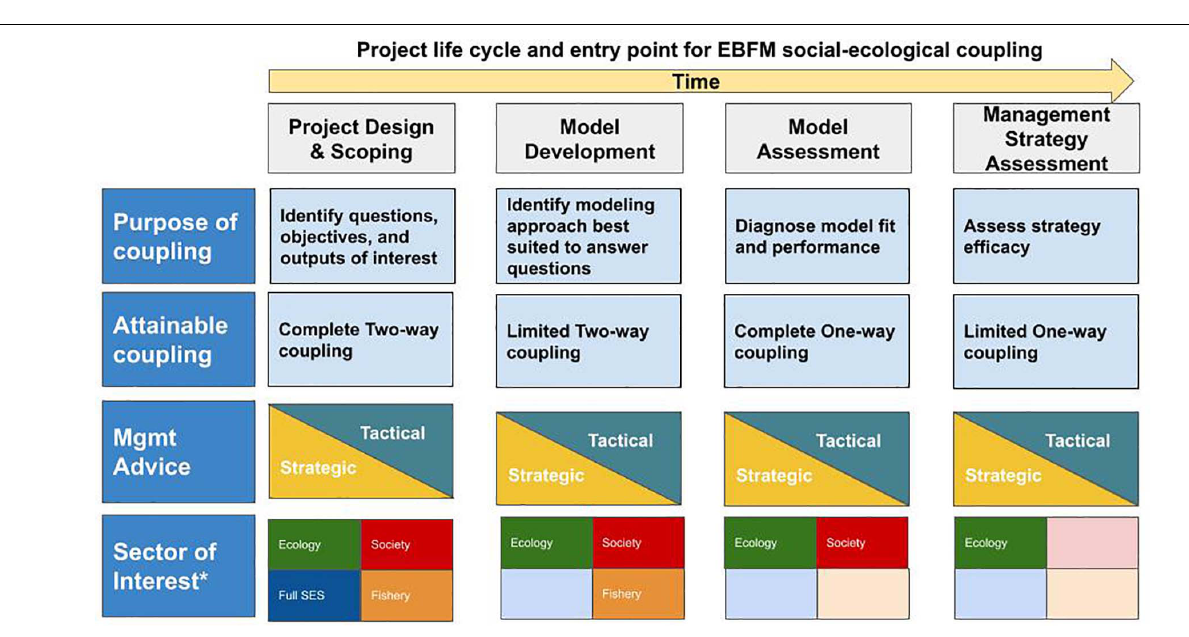
Frontiers in Marine Science |